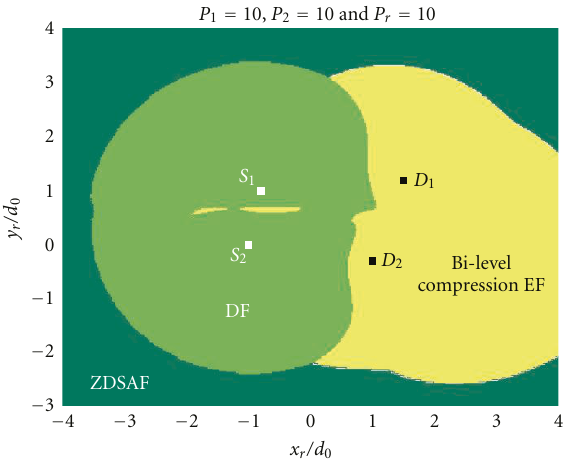
Figure 2: For di ff erent relay positions in the plane ( x r /d 0 , y r /d 0 ) ∈ [ − 4,+4] × [ − 3,+4], the figure indicates the regions where one relaying protocol (AF, DF or bi-level EF) dominates the two others in terms of network